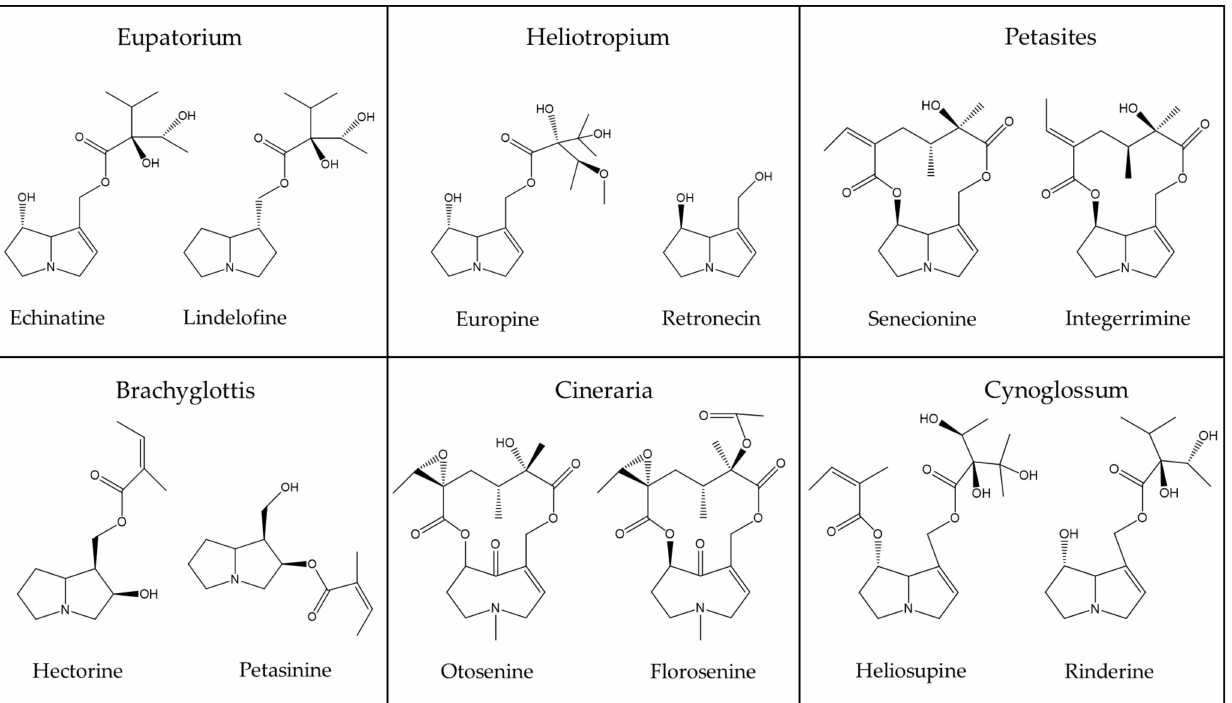
Figure 3. Examples of pyrrolizidine alkaloids reported for typical phytochemicals found in plants of the genera Eupatorium , Heliotropium , Petasites , Brachyglottis , Cineraria , and Cynoglossum. With the exemption of Lindelofine, all other PAs are unsaturated and have a double bond between C1 and C2. The figure of these chemical structures was obtained from the recent open access publication of Kopp et al.